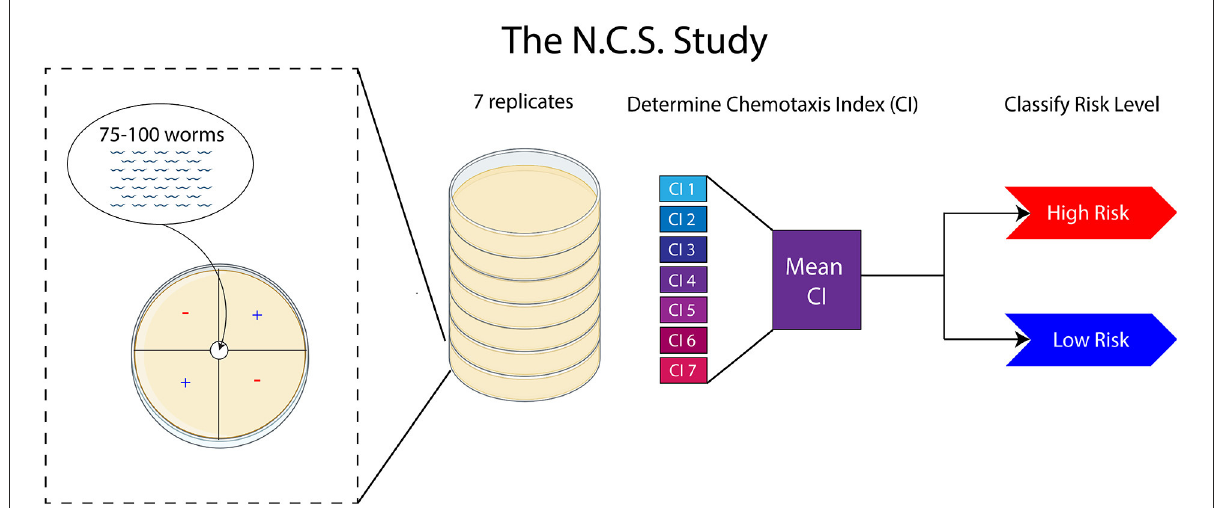
FIGURE1 The N.C.S. Study is conducted by placing 75–100 worms on each assay plate. A total of seven assay replicates are conducted, from which a mean CI is calculated and used to assess the level of cancer risk. Adapted from BioRender.